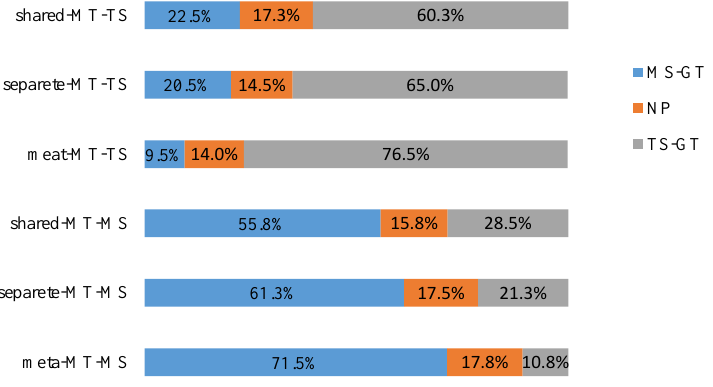
Figure 8. Speaker similarity results of Mandarin speech samples in Tibetan speaker’s (TS) voice generated by shared-MT, separate-MT and meta-MT models, Tibetan speech samples in Mandarin speaker’s (MS) voice generated by shared-MT, separate-MT and meta-MT models. MS-GT and TS-GT are the ground truth of Mandarin speaker and Tibetan speaker, respectively. NP denotes no